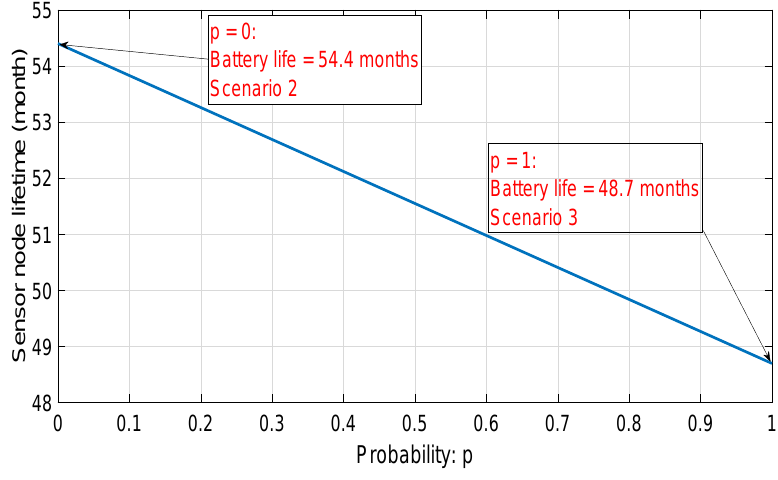
Figure 21. Battery life vs. probability of having Scenario 3.